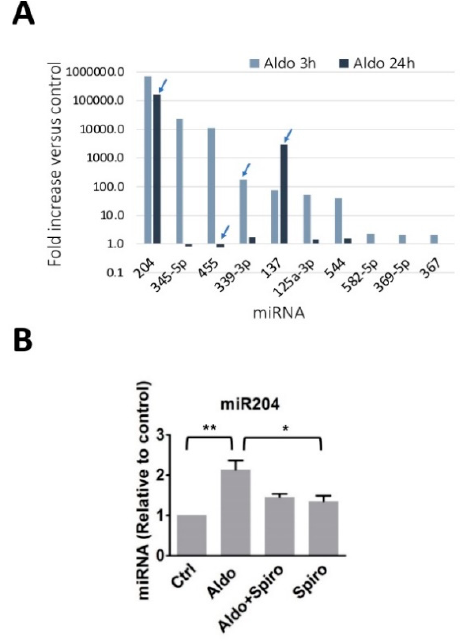
Figure 1. MicroRNA regulation by aldosterone in rat neonate ventricular cardiomyocytes. ( A ) Isolated ventricular cardiomyocytes were incubated for 3 h or 24 h with or without aldosterone (1000 nmol/L). Total RNA was then collected, and miRNA content was analyzed by qPCR on a Taqman low-density